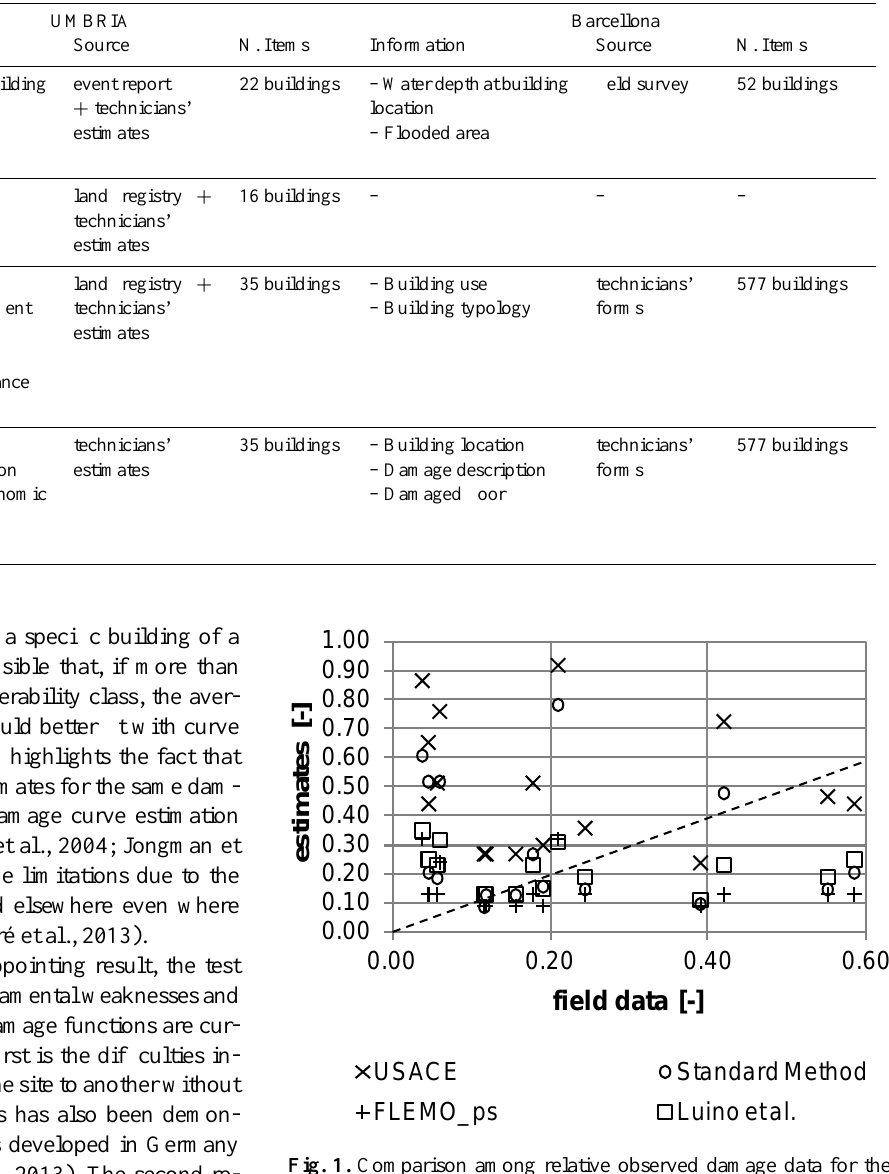
Figure 2. Flood zone in the Ponticelli area, Città della Pieve 25 26